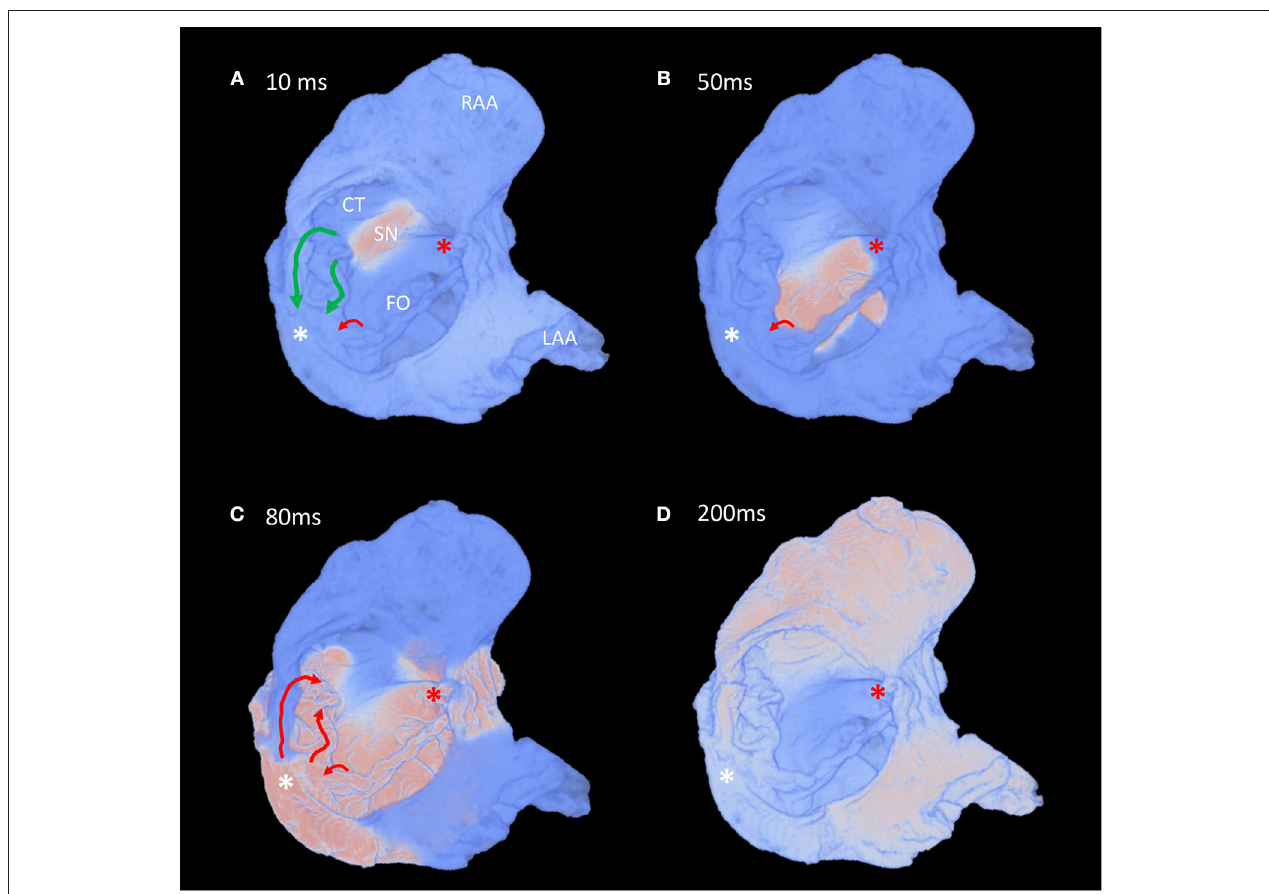
FIGURE 8 | Fast pacing elicits retrograde conduction via the “slow” pathway in the atria of a heart with AVSD. (A–D) Time-lapse snapshots taken from the Supplementary Video 3 showing preferential inter-nodal conduction via the region normally associated with the “fast” pathway, and subsequent retrograde conduction up the “slow” pathway, during an atrial pacing protocol (s1-s2 interval 300ms). Views are comparable to those presented in Figure 7 . The normal location and direction of the “slow” pathway (green), and the septal aspect of the elongated “fast” pathway (red) are indicated by solid arrows. Pink indicates activated myocardium, light blue indicates dormant myocardium. See methods for modeling parameters. White*, location of compact atrioventricular node in AVSD heart; Red*, location of compact atrioventricular node in normal heart; CS, coronary sinus, CT, terminal crest; FO, fossa ovale; LAA, left atrial appendage; RAA, right atrial appendage; SN, sinus